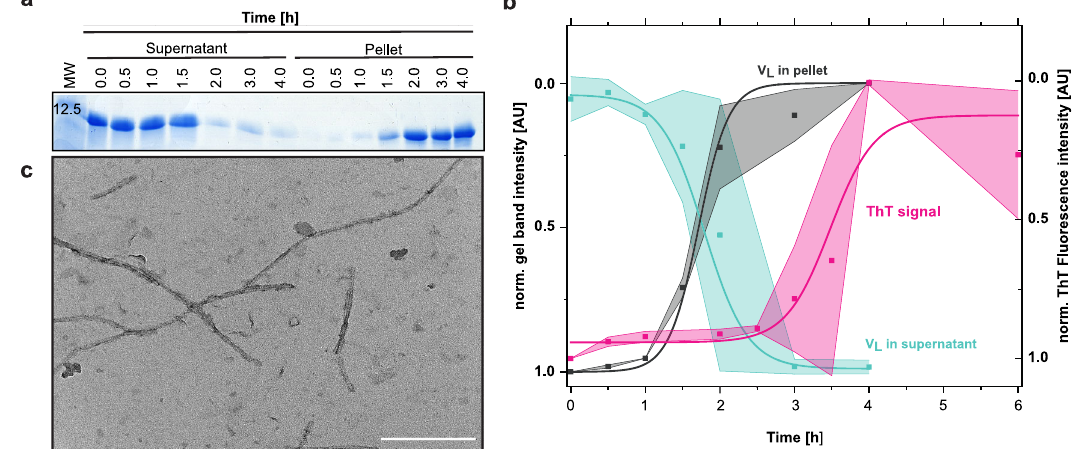
Fig. 1 Transition from soluble V L Pat-1 to insoluble fi brils. a Soluble and insoluble fractions of Pat-1 V L during incubation at amyloid-promoting conditions. Samples were taken at the timepoints indicated and run on an 18% SDS-gel. b Quanti fi ed and normalized band intensities of the SDS-gel are shown in turquoise for the soluble V L domain (t 1/2 = 1.79 h) and in black for the insoluble fraction (t 1/2 = 1.71 h). Shades represent the SEM of n = 2. Fibril formation of Pat-1 V L as monitored by ThT fl uorescence is shown in pink (t 1/2 = 3.48 h). Values were fi t to a Boltzmann function Shades represent the SEM of n = 3. c TEM micrograph of fi brils formed after 3 h of incubation. The scale bar represents 200